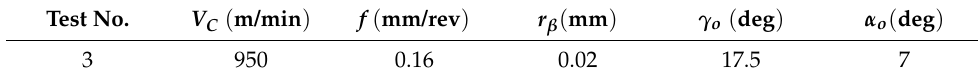
Table 3. Cutting conditions and tool geometry for the validation test.